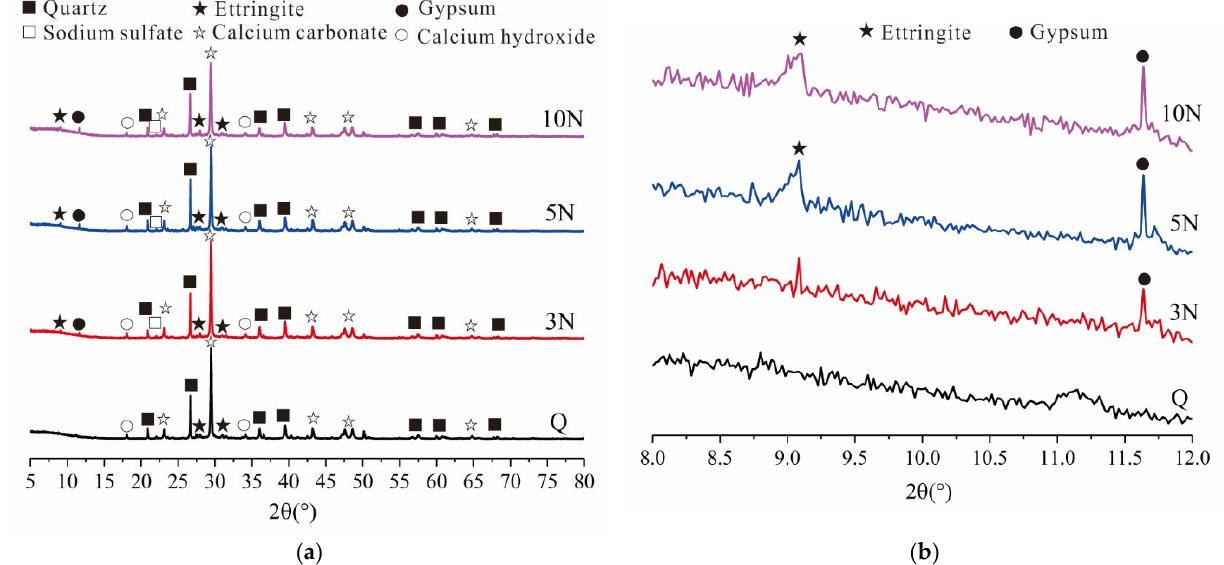
Figure 4. XRD diffractograms of concrete specimens ( a ): XRD of different concentrations of sodium sulfate on day 28 of concrete; ( b ): the first peaks of AFt and gypsum.